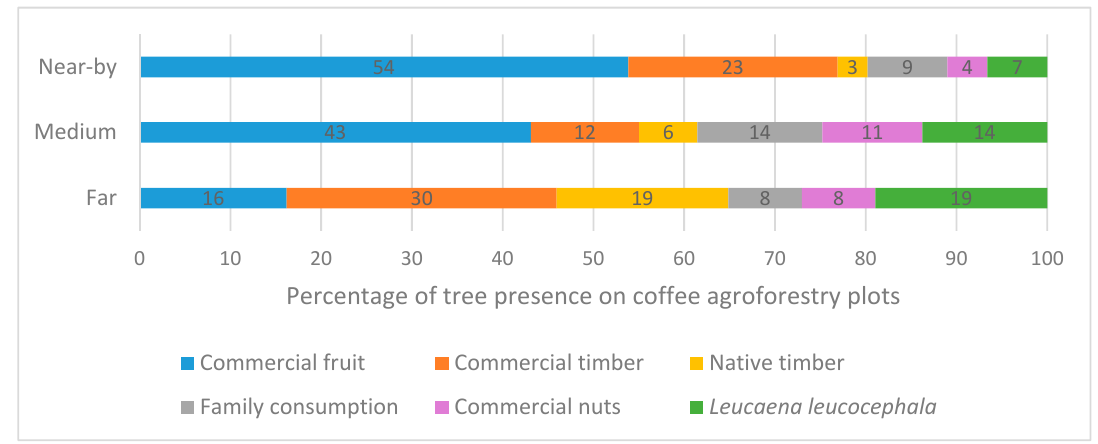
Figure 4. Percentage of tree species present in coffee agroforestry plots with respect to proximity to the road (Note: number of farmers near the road was 52, medium to road was 54, far from road is 18). Land 2020 , 9 , x FOR PEER REVIEW